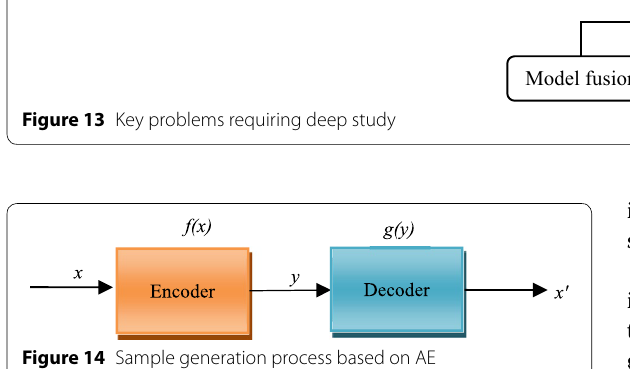
Figure 14 Sample generation process based on